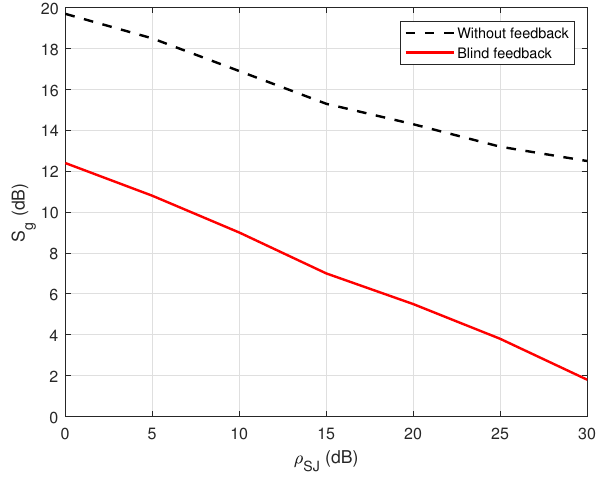
Figure 12. S g versus ρ SJ in the case of a passive